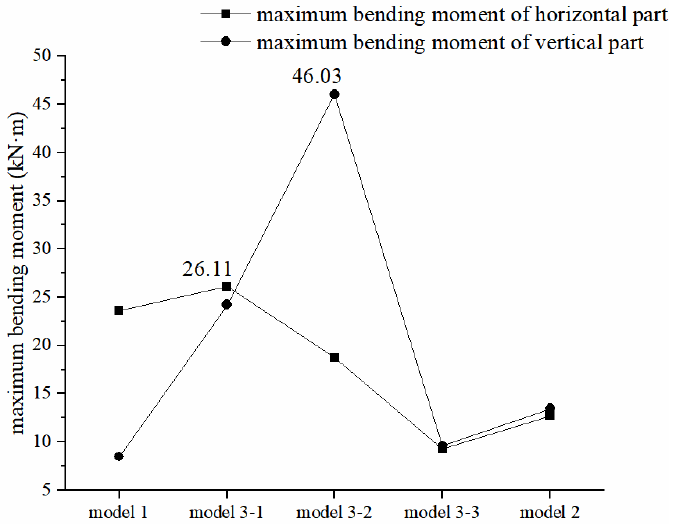
Figure 16. Maximum bending moments of the horizontal part and vertical part for the sH-shaped components in each model.